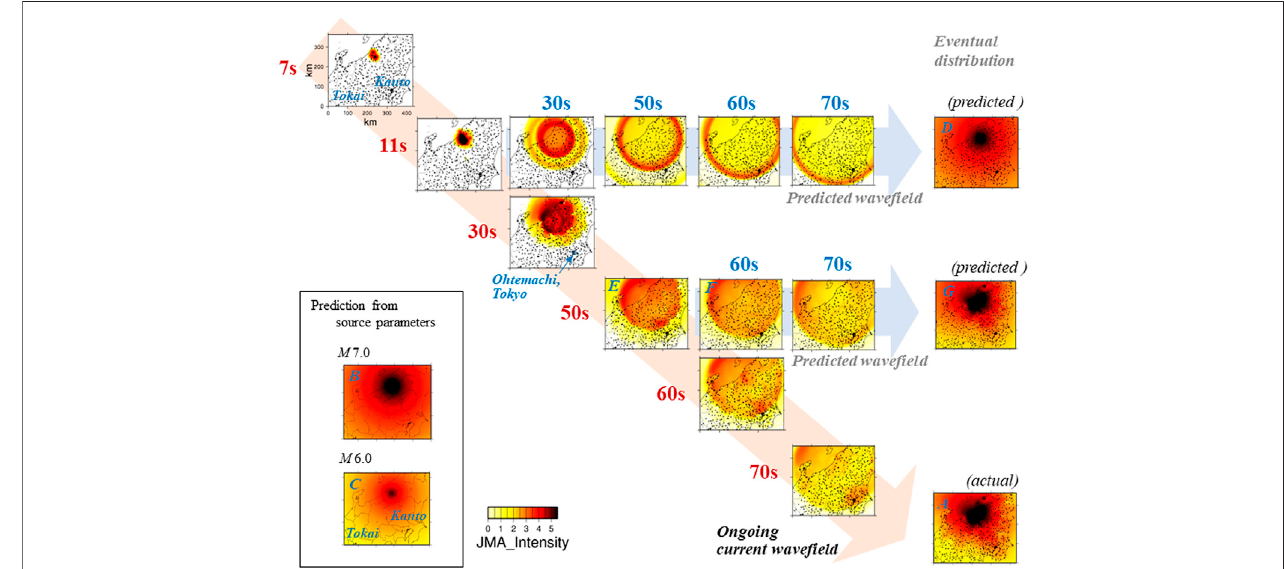
FIGURE 6 | An example application of the wave fi eld based method using a Mw6.4 earthquake (the largest aftershock of the Mw6.7 Chuetsu, Niigata, Japan earthquake; October 23, 2004). Data from K-NET and KiK-net of the National Research Institute for Earth Science and Disaster Prevention (NIED) were used. The locations of observation points are shown by small dots. The actual eventual distribution of ground motion was complicated (A) relatively strong ground motion was observedatKanto, and weakoneat Tokai.Thiscomplicated distributionisnotreproduced bythesource-based method, asshownin (B,C) usingM7.0and M6.0, respectively. In the wave fi eld-based method, the predicted eventual distribution from the observation at t (cid:2) 11s (D) is similar to the prediction using a M7.0 event (B) . At t (cid:2) 50s, strong ground motions were observed to be propagating toward Tokyo (E) , and the updated prediction indicates the arrival of the strong ground motions at Tokyo at t (cid:2) 60s (F) The predicted eventual distribution from t (cid:2) 50s (G) reproduces well the actual distribution (A)